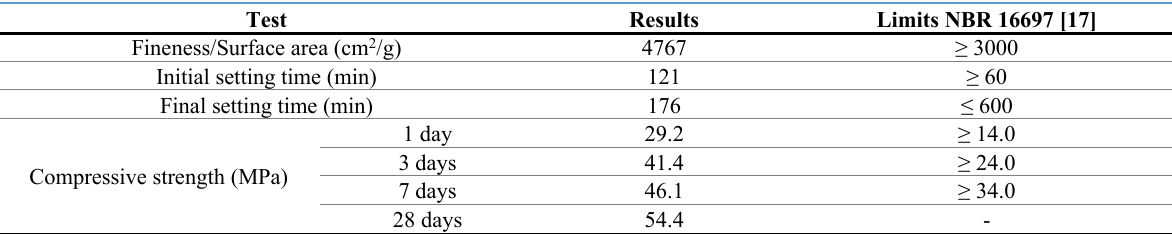
Table 1. Physical characterizations of the cement used.